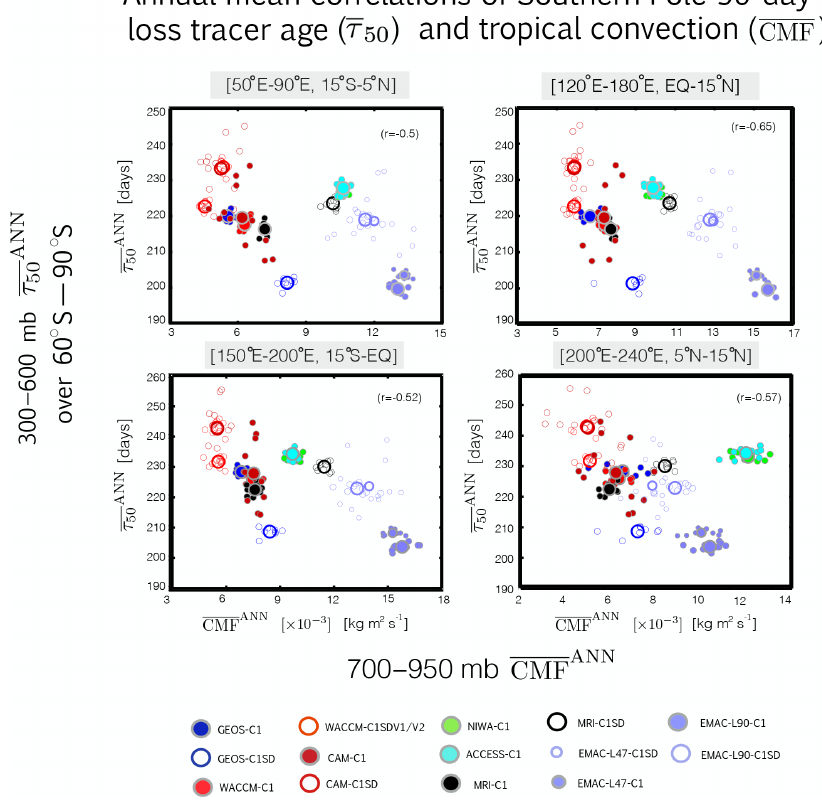
Figure 11. Scatterplots showing negative correlations between the strength of parameterized convection in the tropics, represented by the 700–900hPa averaged convective mass flux (CMF), and mid-tropospheric (300–600mb) values of the 50-day idealized loss tracer age, τ 50 , evaluated over the Southern Pole. The different colors correspond to the different simulations, with open circles denoting REF-C1SD simulations and closed circles corresponding to REF-C1 free-running simulations. Small circles correspond to individual years within the 2000–2009 climatological mean period, while large circles denote the climatological